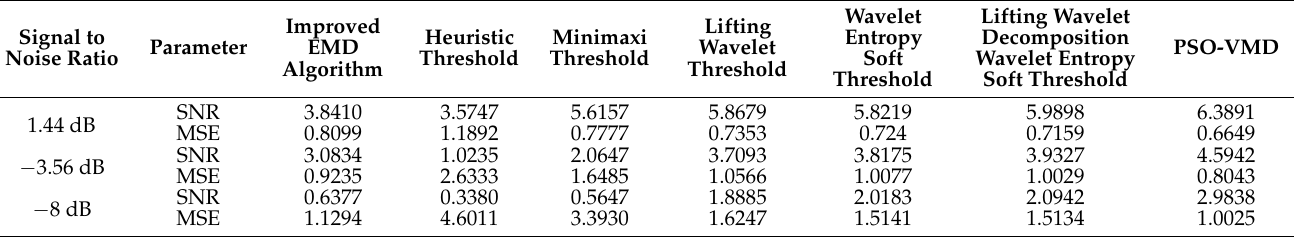
Table 4. Comparison of noise reduction effects for different SNR cases.